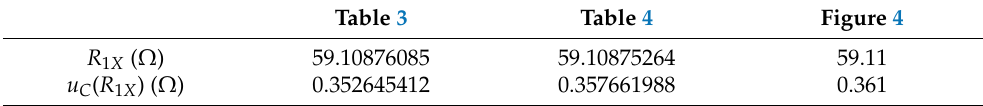
Table 5. Comparative presentation of the results for R 1 X and u C ( R 1 X ) .